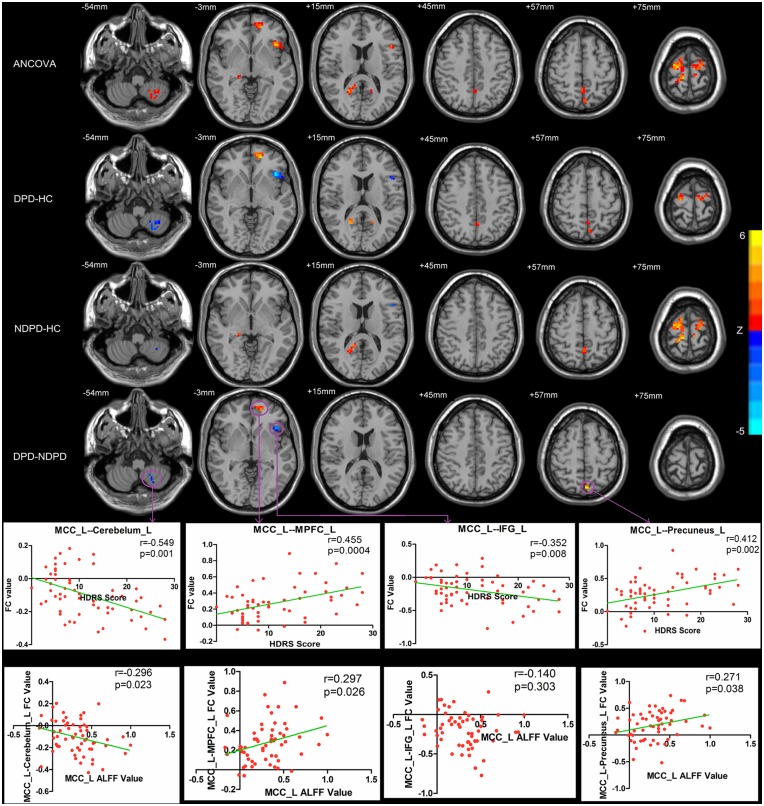
Statistical parametric map showing the significant differences in the MCC FC between three groups: DPD, NDPD and HC.The ANCOVA thresholds were set at a voxel-level p < 0.01, cluster size > 918 mm3 /34 voxels, corresponding to a corrected p < 0.05 as determined by AlphaSim correction. A two-sample post hoc t-test was performed between each pair of the three groups (DPD vs NDPD, DPD vs HC, NDPD vs HC)(voxel-level p < 0.01, cluster size > 162 mm3 /6 voxels, corresponding to a corrected p < 0.05 as determined by AlphaSim correction). Statistical parametric map showing the significant correlations between HAMD score and FC value in left MCC and other ROIs. Statistical parametric map also showing the significant correlations between ALFF value of left MCC and FC value in left MCC and other ROIs.